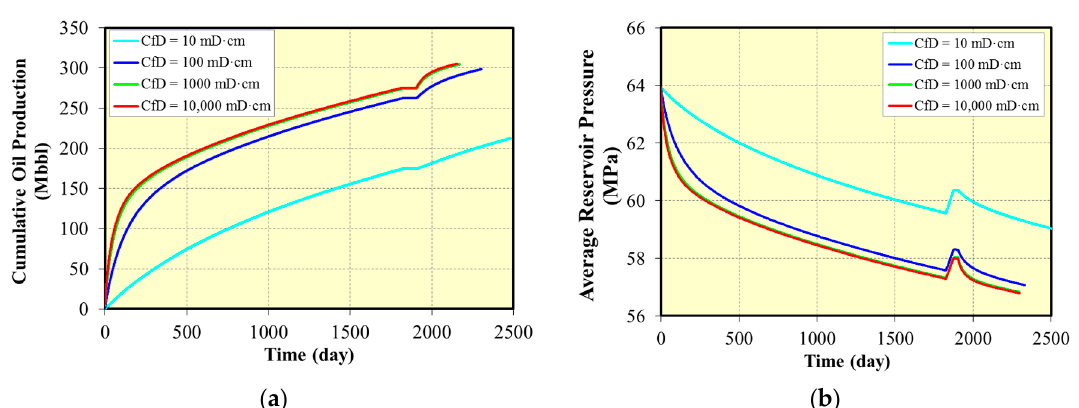
Figure 19. Effect of different fracture conductivity with one huff-n-puff cycle on oil production and reservoir pressure: ( a ) Cumulative oil production for different fracture conductivity; ( b ) Average reservoir pressure for different fracture conduc- tivity.